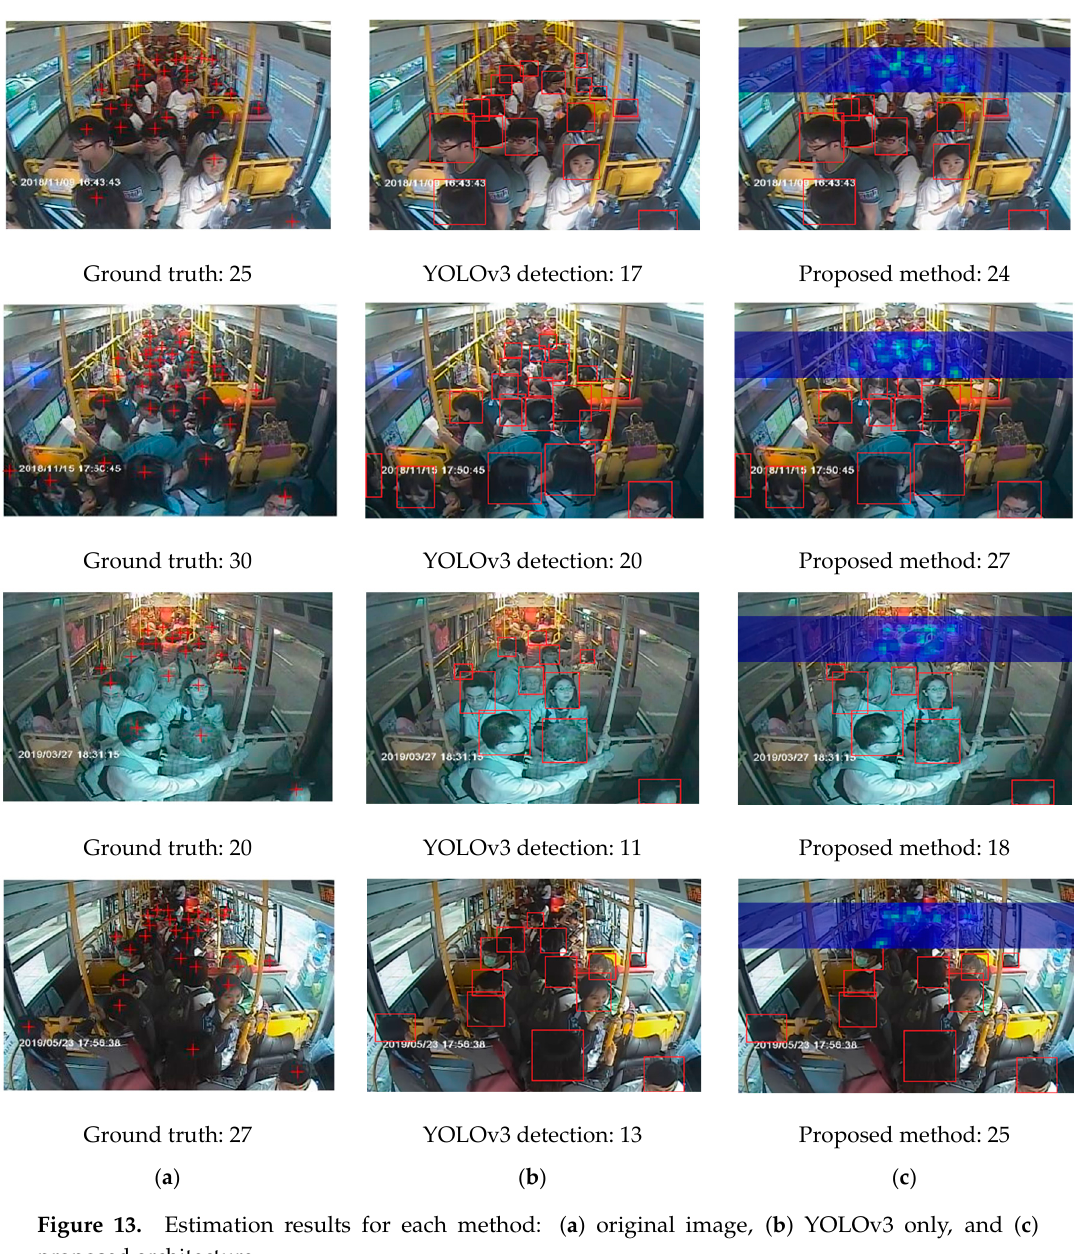
Figure 13. Estimation results for each method: ( a ) original image, ( b ) YOLOv3 only, and ( c ) proposed architecture.